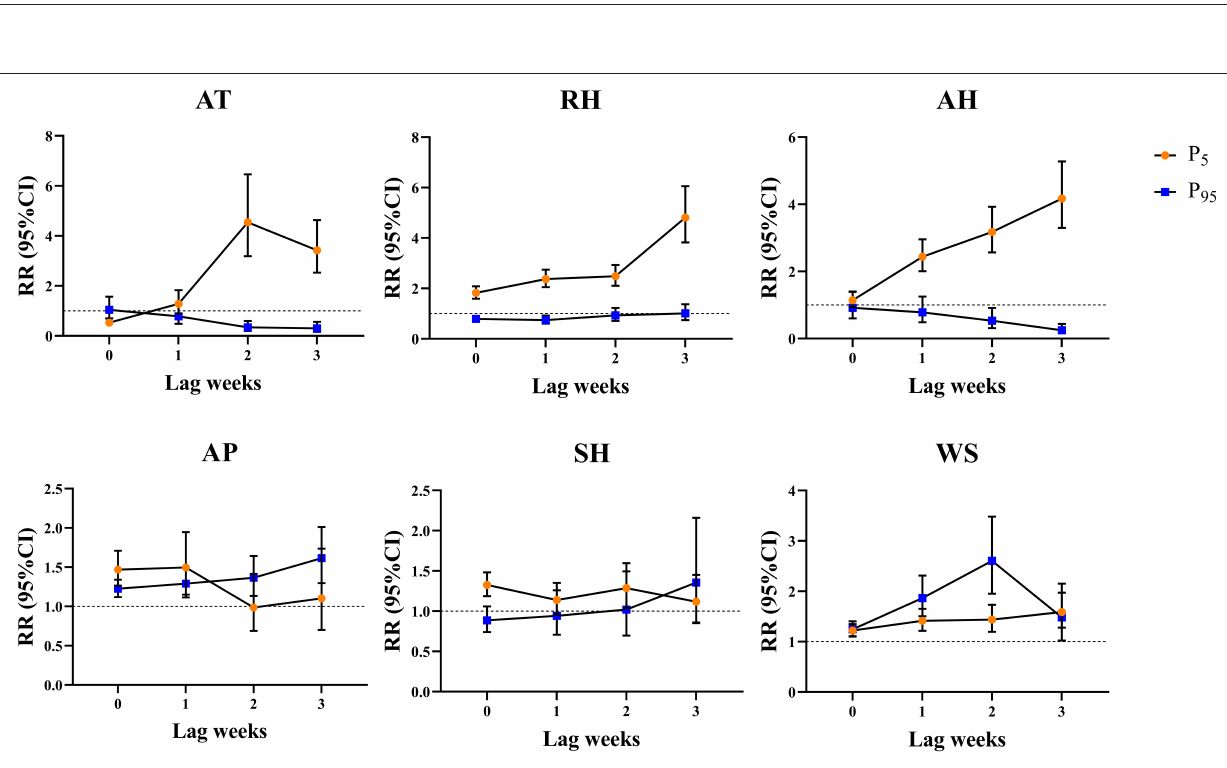
FIGURE 3 | Cumulative lag effect of meteorological parameters on the onset of influenza under extreme conditions at different lag weeks in Lanzhou, China during 2010–2019. P 5 represents the 5th percentile. P 95 represents the 95th